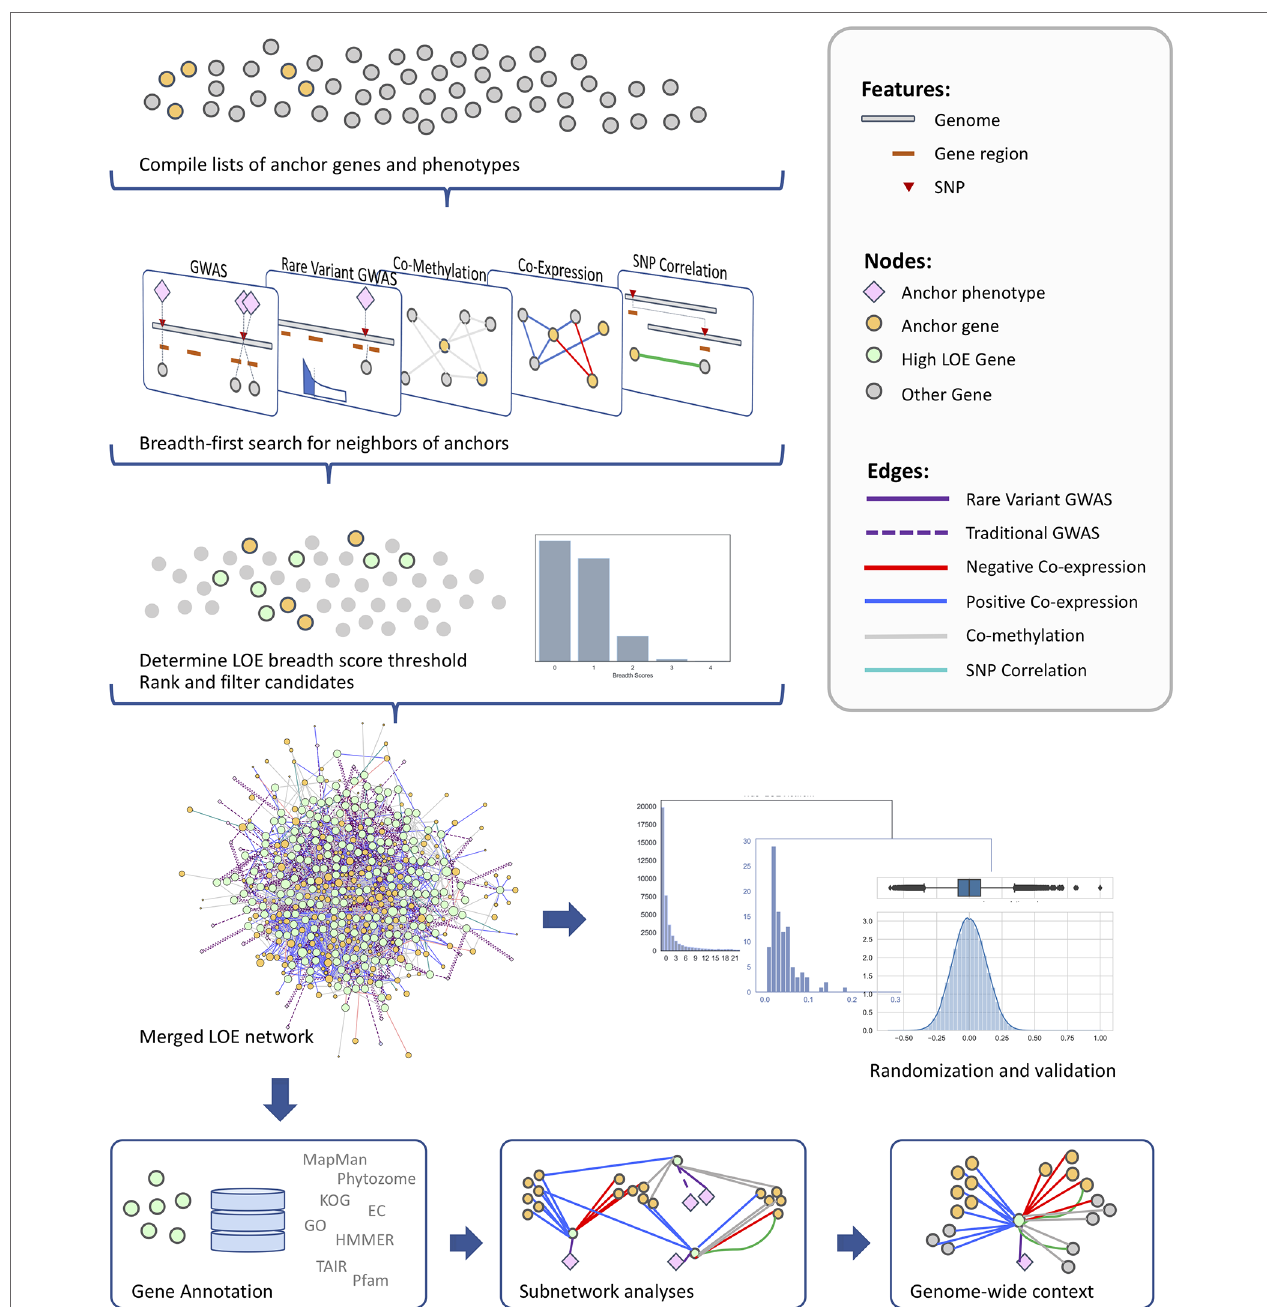
FIGURE 1 | Overview of the method for identifying new candidate genes involved in cell wall regulation through data layering and calculation of LOE